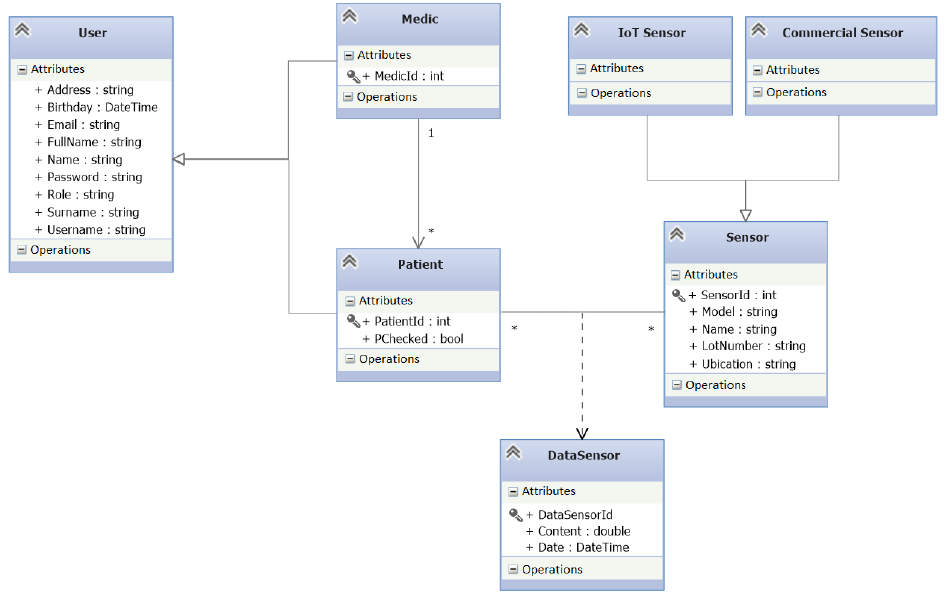
Figure 3. Database diagram of the